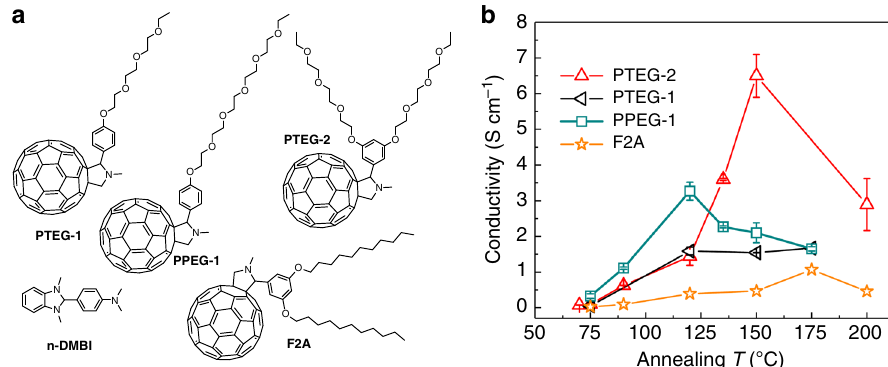
Fig. 1 Side-chain variations and thermal annealing effect. a Chemical structures of different fullerene derivatives (PTEG-1, PTEG-2, PPEG-1, and F2A), and dopant (n-DMBI); b Plots of electrical conductivity at room temperature as a function of the annealing temperature for different fullerene derivatives doped at a concentration of 8 wt% n-DMBI. Error bars indicate the standard errors of the mean values of electrical conductivity obtained by the measurement of six different samples.